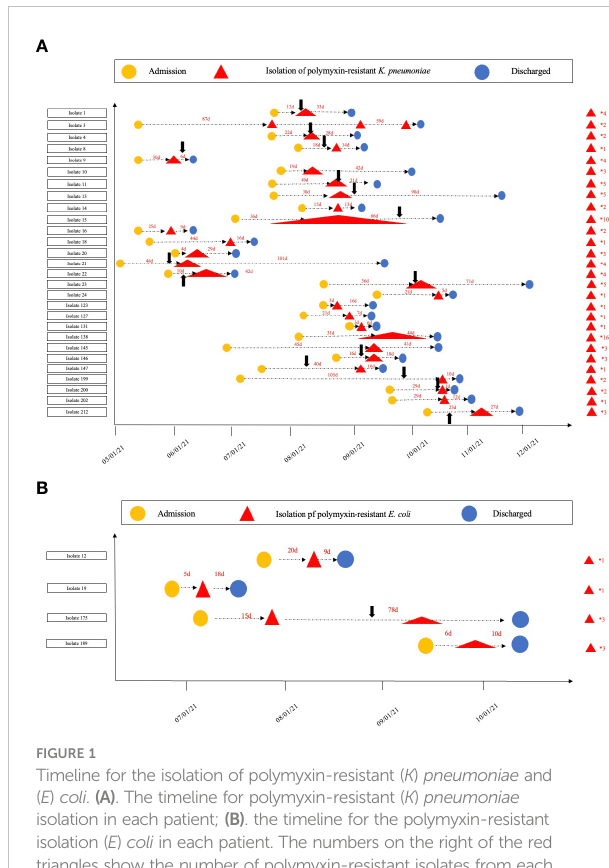
FIGURE 1 Timeline for the isolation of polymyxin-resistant ( K ) pneumoniae and ( E ) coli . (A) . The timeline for polymyxin-resistant ( K ) pneumoniae isolation in each patient; (B) . the timeline for the polymyxin-resistant isolation ( E ) coli in each patient. The numbers on the right of the red triangles show the number of polymyxin-resistant isolates from each patient. The black arrows show when polymyxin treatment